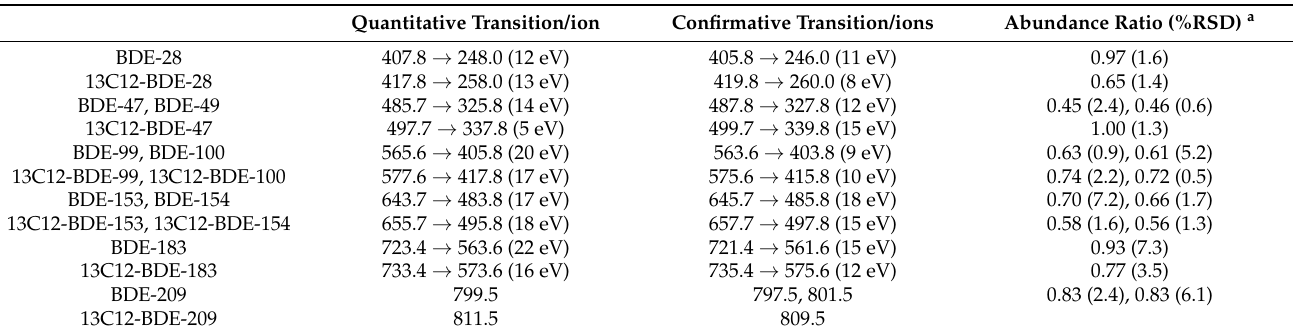
Table 1. MRM transitions with optimised collision energies (CE) for BDE-28 to BDE-183 and selected SIM m/z for